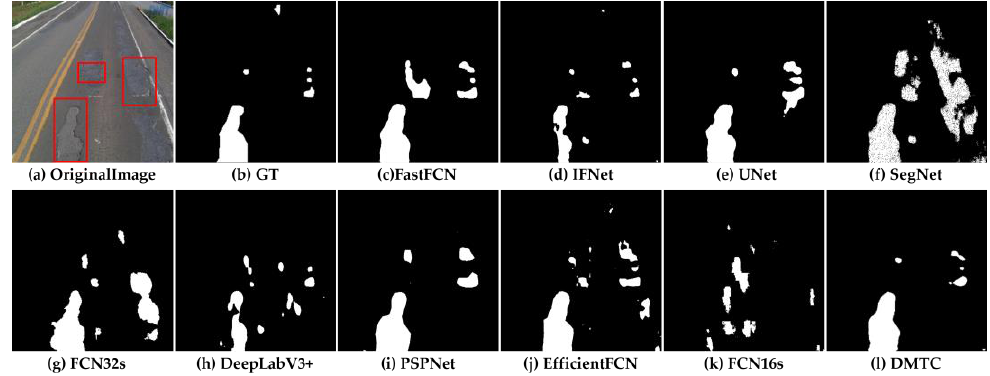
Figure 7. Visual comparison of the results of a series of segmentation methods for medium potholes on CPRID. There is a red outline around the pits in the original image, a white outline around the pits in the label map and segmentation map, and black in the rest of the background.